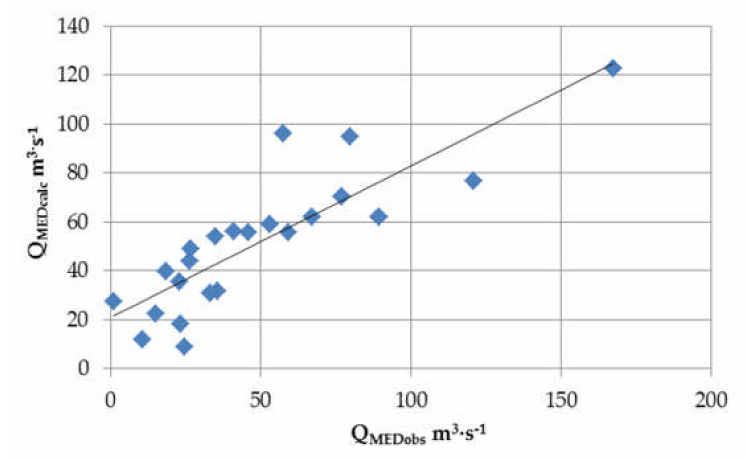
Figure 14. Comparison between observed and calculated Q MED in mountain catchments of the Upper Vistula basin; the line represents the best fit of the model to observed values.